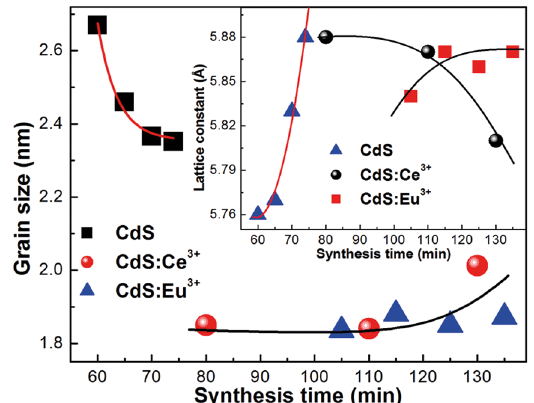
Figure 3. It illustrates the grain size as function of synthesis time for single CdS and RE-doped CdS. The inset shows the